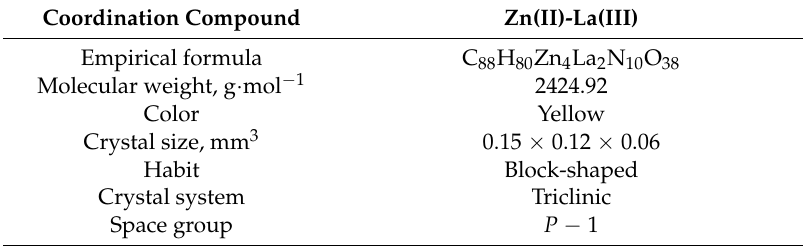
Table 1. Crystal data and structure parameters for the Zn(II)-La(III) coordination compound.